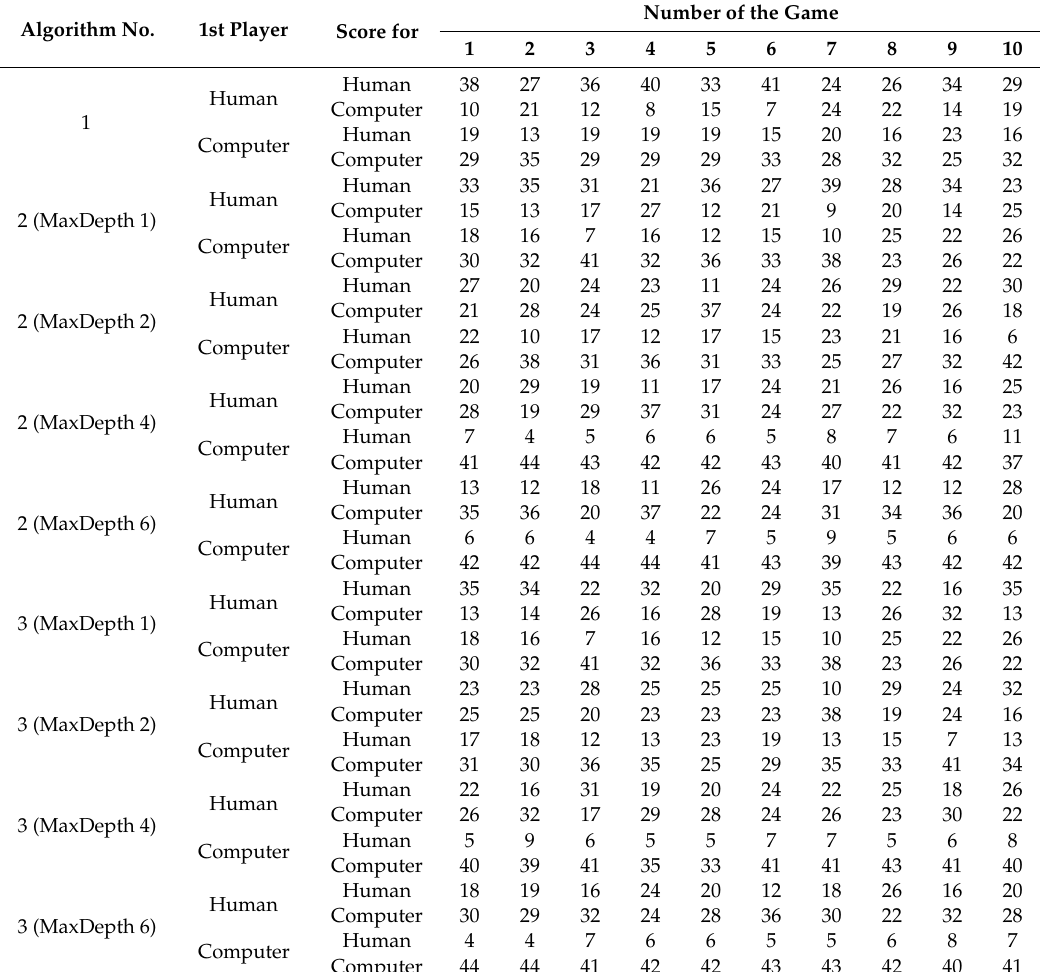
Table 1. Scores of the human player and the